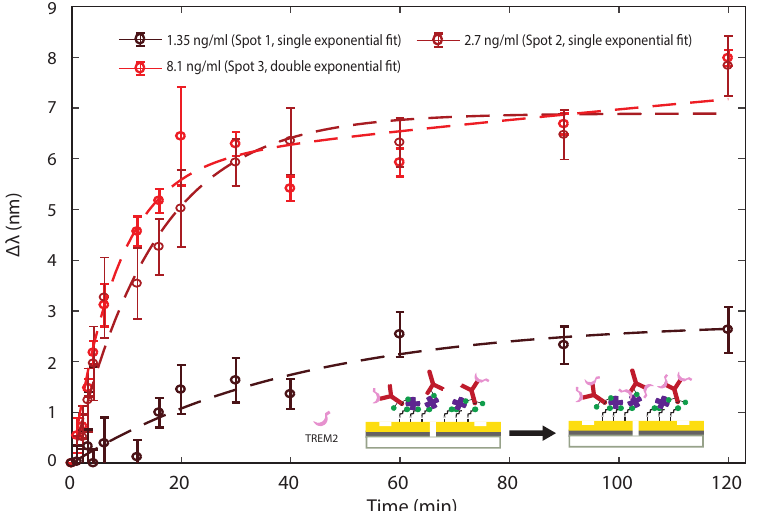
Figure 6. Binding times for different TREM2 concentrations. Temporal evolution of peak wave- length shifts measured from normalized transmission spectra for different TREM2 concentrations. Error bars represent standard deviation from 7 GSG interferometers. Dashed lines represent expo- nential fit using the kinetic model provided in the